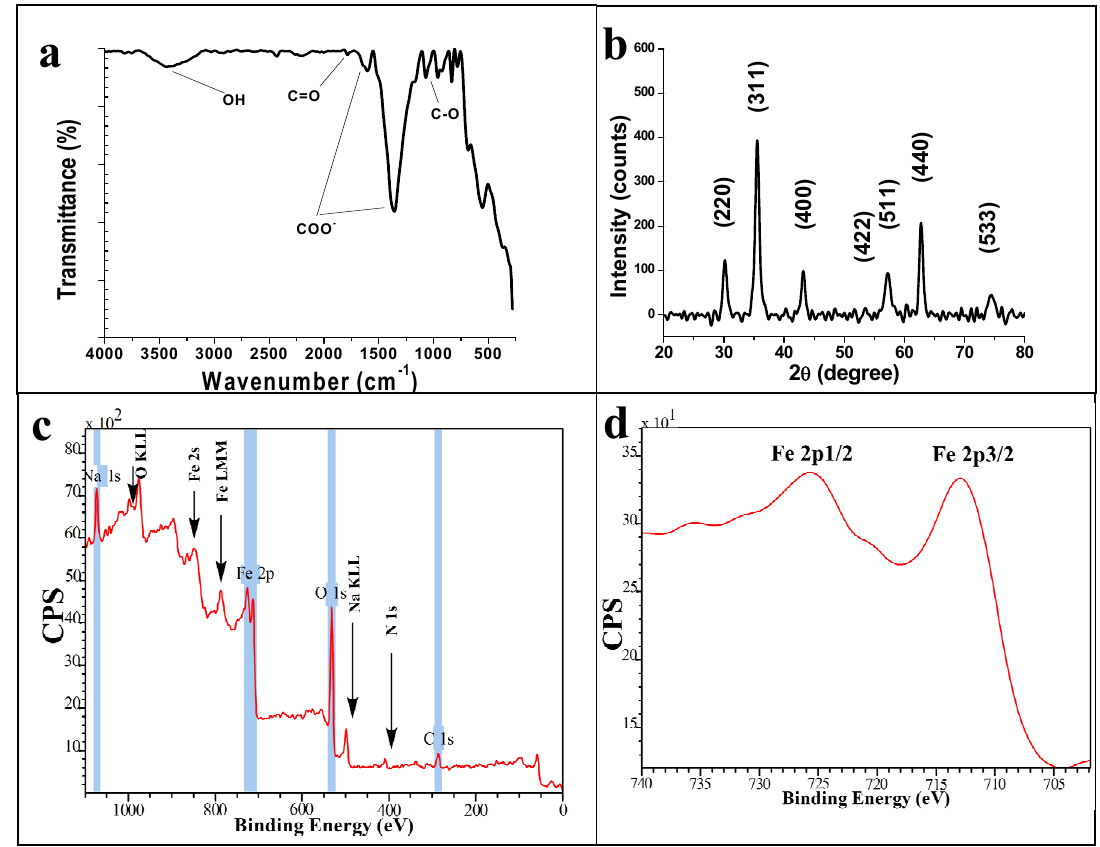
Figure 3. Characterization of structure of synthesized MNPs and their surface functional groups. ( a ) FTIR spectra of synthesized particles; ( b ) XRD pattern; ( c ) XPS of particles and ( d ) The detail of Fe peak region in 2p